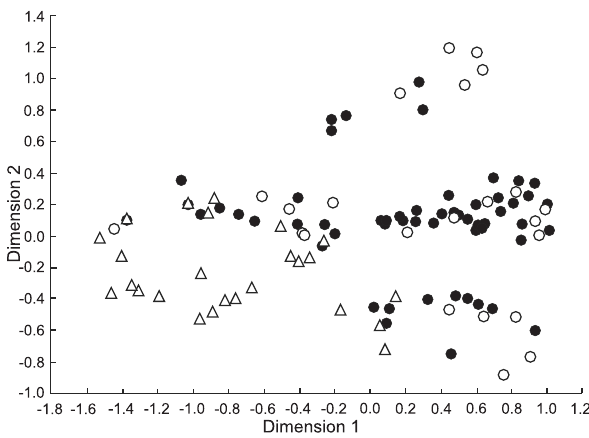
Figure 2. MDS ordination using occurrences of behavioral events grouped by behavioral states. Stress: 0.14. ( (cid:122) ) feeding, ( (cid:123) ) travel- ling, ( (cid:83) ) socio-sexual.